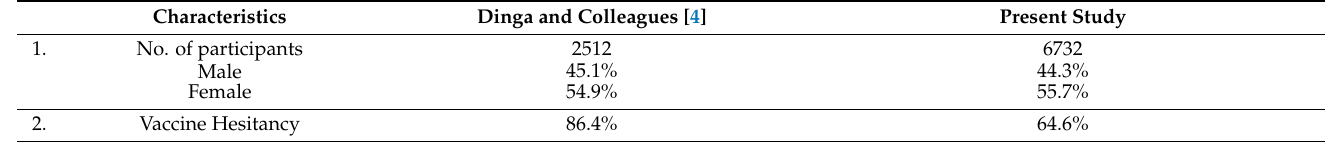
Table 2. Comparative analysis of two cross-sectional studies on vaccine hesitancy in Cameroon.